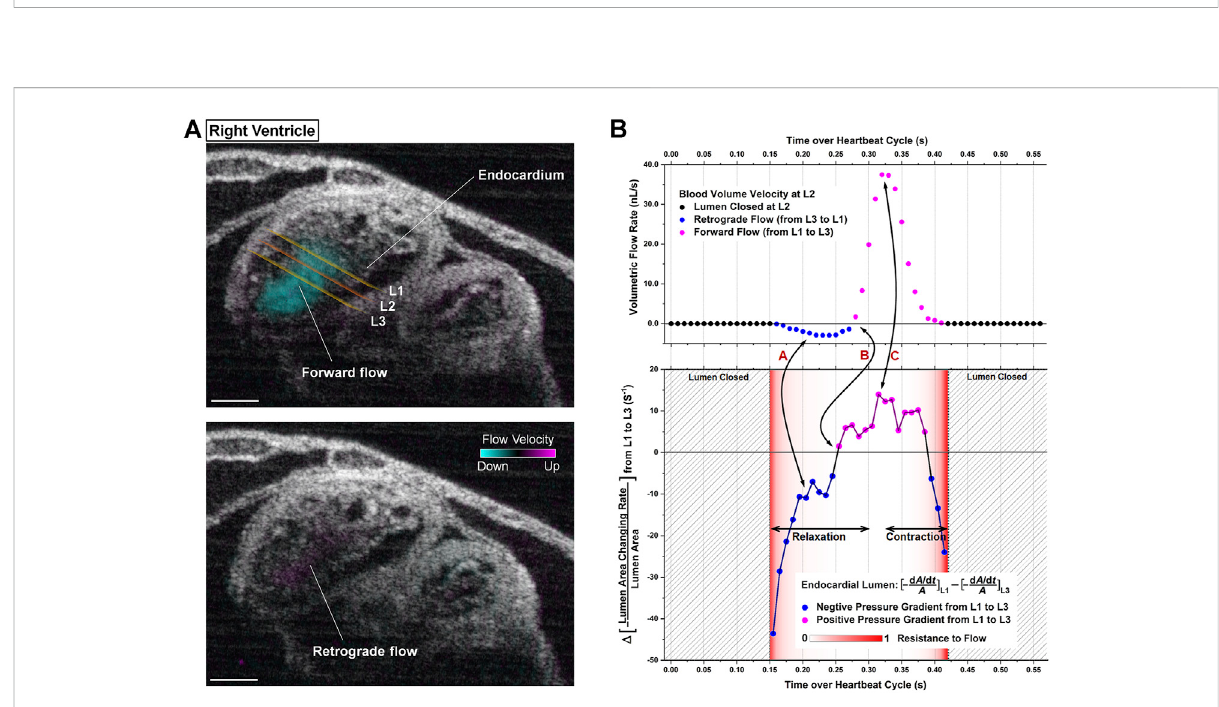
FIGURE 3 4D-OCT analysis of cardiac pumping in the right ventricle of E9.25 embryonic heart. (A) Structural and color-coded Doppler 4D-OCT fl ow images of the beating heart. The positions of the measurement planes where the analysis was performed are labeled as L1, L2, and L3. (Scale bar: 100 µm). (B) Correspondingquantitativeanalysisde fi ningtherelationbetweenpressuregradient,resistanceto fl ow,andvolumetric fl owratetoward the localized pumping investigation. Reproduced from (Wang and Larina,